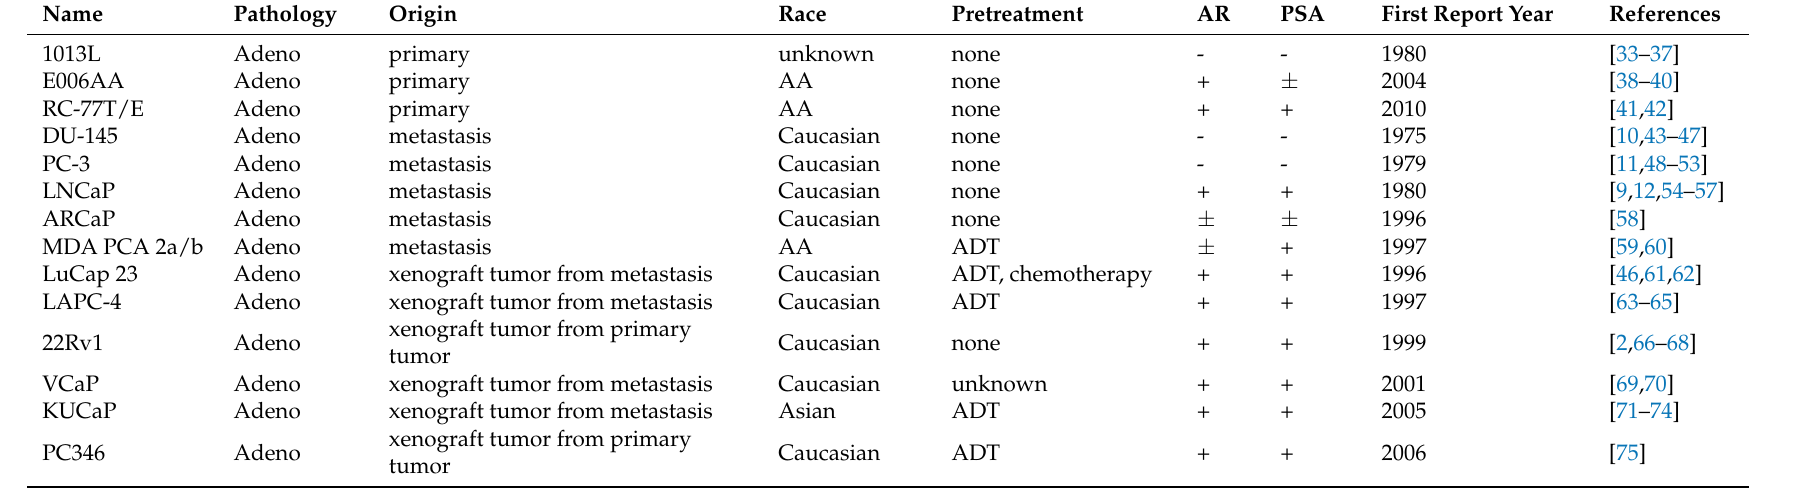
Table 1. Established prostate cancer cell